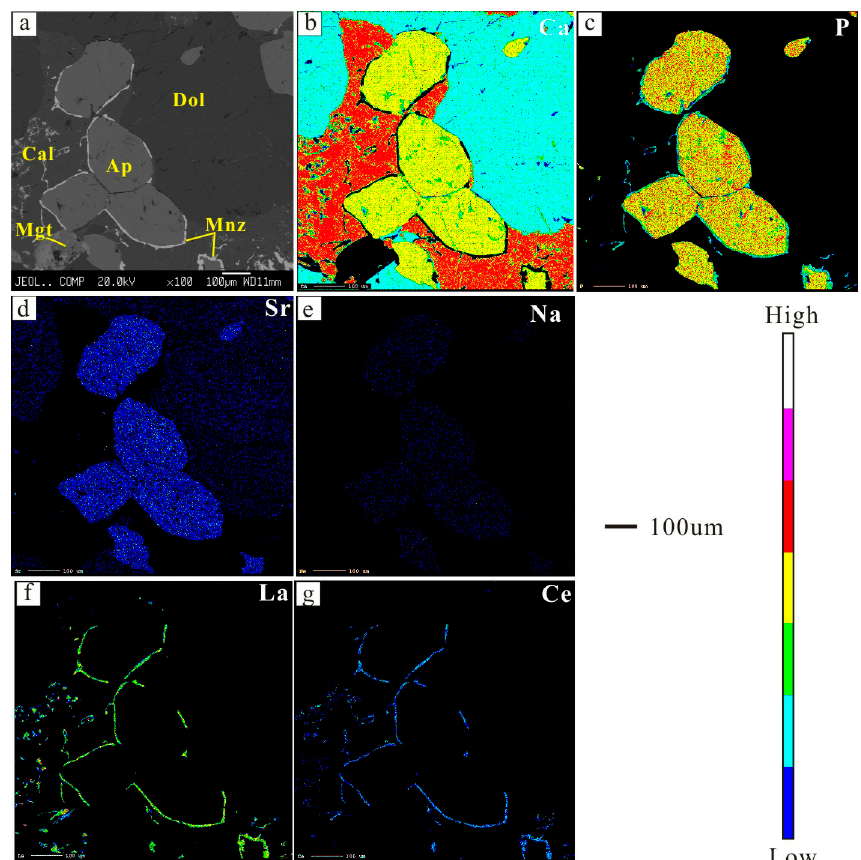
Figure 10. Backscattered electron and X-ray element mapping images of Type 2 apatite. Legend to the right refers to element concentrations from low to high, but not to scale. ( a ) BSE image of Type 2 apatite. ( b ) X-ray element mapping image of calcium. ( c ) X-ray element mapping image of phosphorus. ( d ) X-ray element mapping image of strontium. ( e ) X-ray element mapping image of sodium. ( f ) X-ray element mapping image of lanthanum. ( g ) X-ray element mapping image of cerium. Abbreviations